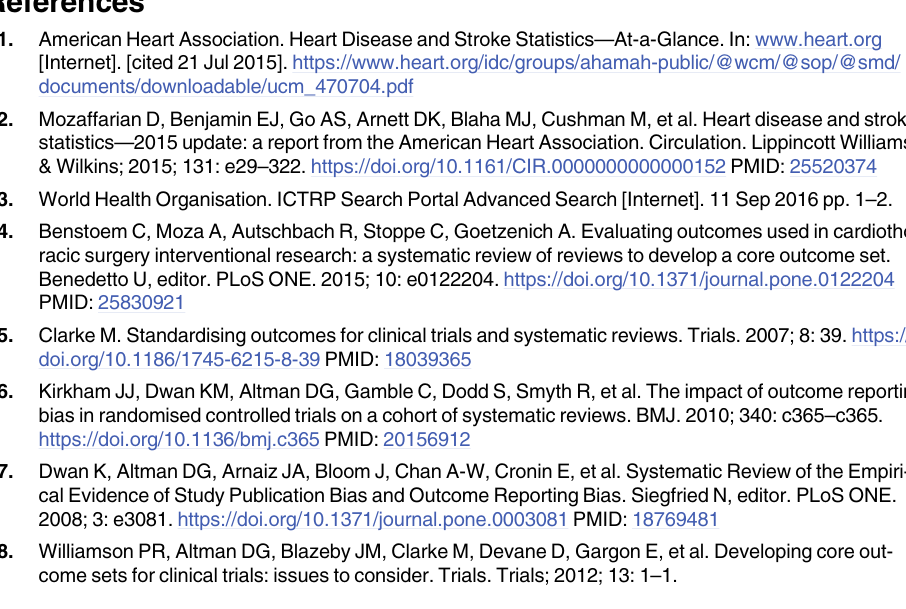
S4 Fig. Round 3 of eDelphi: Rating for 17 potential core outcomes, core area pathophysio- logical manifestation.